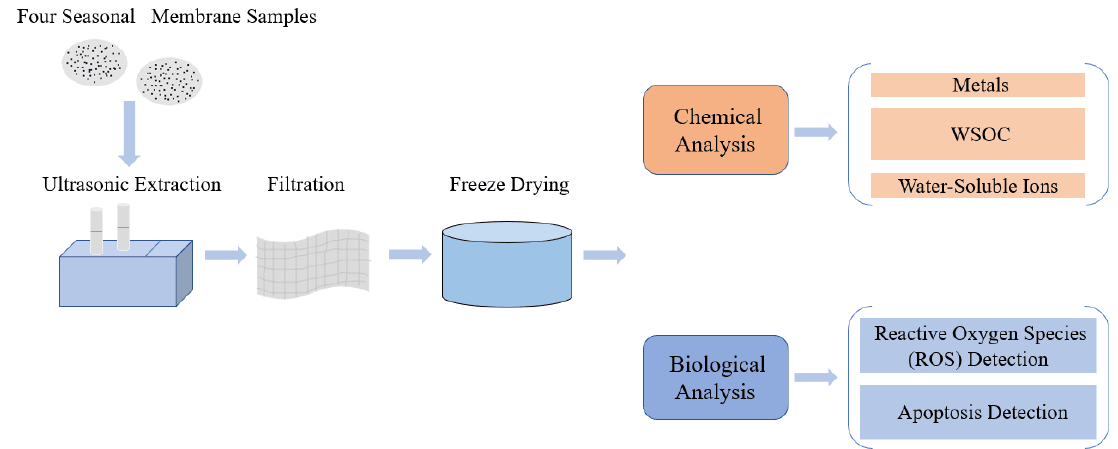
Figure 1. Schematic of the experimental design. WSOC: water-soluble organic carbon.